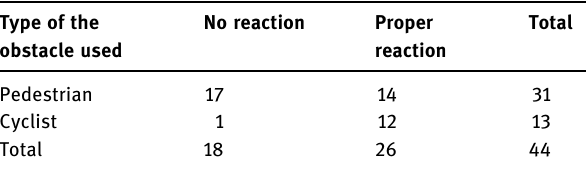
Table 2: System reactions depending on the obstacle used Type of the